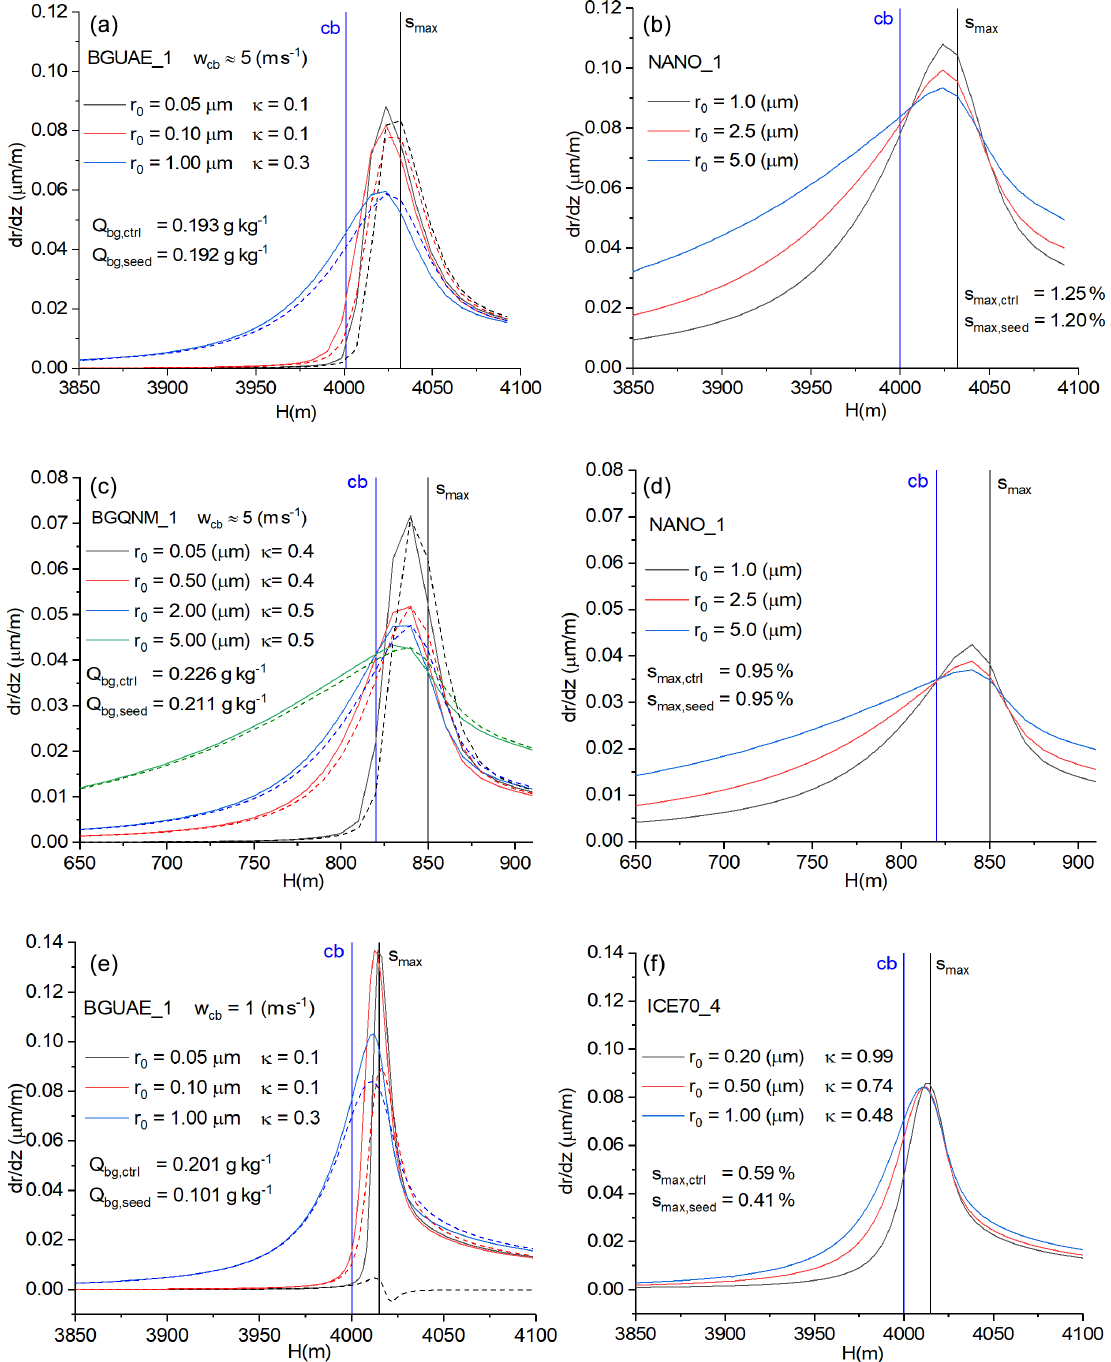
Figure 6. The vertical profiles of the growth rate of drops formed on background aerosol particles with different sizes and hygroscopicities (a, c, e) and those formed on different types of seeding materials with different sizes and hygroscopicities (b, d, f) . In the left panels, the solid lines denote control cases, and the dashed lines denote seeded cases. Blue and black vertical lines denote the location of the cloud base and that of the maximum supersaturation. The s max , ctrl and s max , seed mean the calculated maximum supersaturation belongs to the unseeded and seeded cases, respectively. The Q bg , ctrl and Q bg , seed mean the amount of the condensed water on the background aerosol particles in the control and seeded cases at 100m above the cloud base,